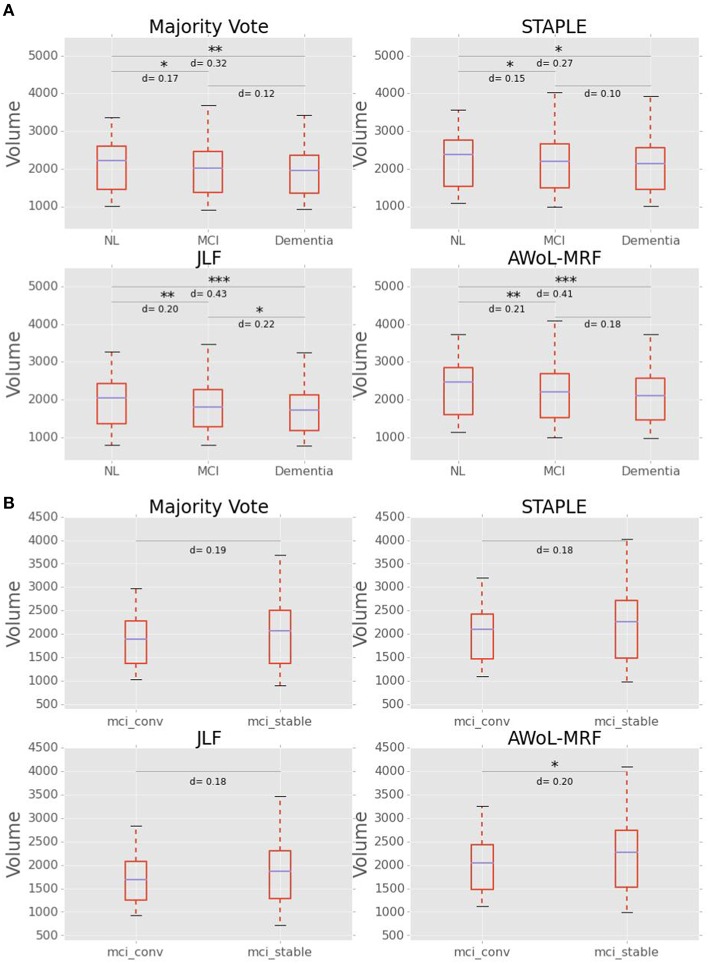
(A) Hippocampal volume (in mm3) vs. diagnoses (NL vs. MCI vs. AD). Cohen's d scores (effect size) and statistical significance is reported for pairwise comparisons between diagnostic groups. (B) Hippocampal Volume (in mm3) vs. MCI subgroups (converters vs. stable). Cohen's d scores (effect size) and statistical significance is reported for pairwise comparisons between groups.